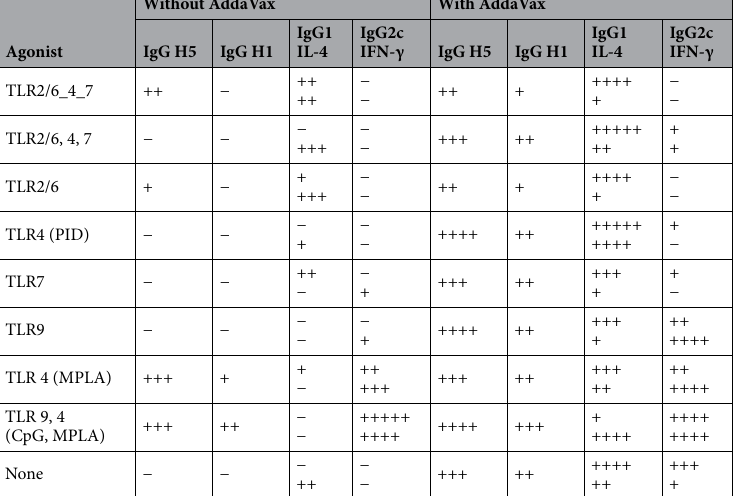
Overall, three main arms are delineated: T lymphocytes (which also includes NK/T cells, γδ T cells, and Tregs), B lymphocytes, and myeloid cells (myeloid dendritic cells, macrophages, monocytes and neutrophils). Interest- ingly, the unbiased hierarchical clustering of cell type transcription profiles placed B cells more closely related to myeloid cells than to T cells. The major cell populations were well delineated by marker genes. Thus, the T cells cluster show elevated expression of Trac, Trbc2, Cd3g and Cd3d (TCR α and β chain constant domains, and CD3γ and δ chains, respectively). Others include Ms4a4a and b (CD20 homolog expressed on mature Th1 cells 45 ); Tcf7 (T cell-specific transcription factor 46 ); and Skap1 (regulator of TCR signaling through MAP kinase 47 ). Nkg7 and Ctsw genes (NK cell granule protein 7 and cathepsin W) are particularly elevated in NK/T cells and play roles in cell-mediated killing by NK and CD8 T cells 48,49 . Also of note is expression of Il2rb (IL2 receptor β chain) which is expressed in NK/T and regulatory T cells (Tregs) at this time point. Also expressed in Tregs is the signature gene Izumo1r ( Folr4 ; folate receptor) 50,51 . The B cells arm shows elevated expression of Cd79a and Cd79b (BCR CD79α and β chains); Ebf1 (B cell-specific transcription factor 52 ); Ighm (IgM heavy chain); and Cd74 (MHC class II invariant chain 53 ). Cells in the myeloid cell express Fcer1g (IgE Fc receptor); Tyrobp (an immunoreceptor-associated tyroskine kinase); and Ifitm3 (IFN-induced transmembrane protein 3), an anti-viral protein which restricts the entry of several viruses into host cells 54 . Among the myeloid cells, neu- trophils show expression of S100 family proteins, including S100a8 and S100a9 (myeloid-related proteins 8 and 14), which are known to be released by activated phagocytes and amplify the inflammatory effect of LPS medi- ated through TLR4 55 . Also expressed in neutrophils is Msrb1 (methionine reductase) which appears to enhance the expression of anti-inflammatory cytokines by macrophages 56 , and Hp (haptoglobulin), a major acute phase protein. These data serve as an additional verification that the SVM correctly identified the cell types. Interest- ingly we found a small population of B and T cell doublets which were identified due to their expression of both T cell markers (Cd3g) and B cell markers (Cd79a) and an unbiased doublet detection algorithm (Supplementary Fig. S3B–D). Doublets in droplet-based sequencing platforms can be indicative of juxtacrine signaling. We then asked whether the differential IgG2c>IgG1 response characterized above could be corrobo- rated using the transcriptomic data. We found Ighg2c , Ighg2b and Ighg1 genes were all upregulated in B cells from immunized mice relative to naïve mice (Supplementary Fig. S4 and Fig. 8C), with log2-fold changes of 6.21 (p-value = 2.14 × 10–93), 4.35 (p-value = 2.33 × 10–281) and 2.69 (p-value = 1.10 × 10–158), respectively (Mann–Whitney U rank-sum test). This is consistent with the moderately skewed IgG2c>IgG1 response observed by IgG isotyping after IVAX-1 administration (Fig. 5a). We also compared the expression of the Ifng gene in naïve and immunized mice (Fig. 8D), which showed IFNγ was expressed by both CD4 and CD8 T cells, with log2-fold increases of 0.7 (p-value = 0.28) and 0.9 (p-value = 0.69), respectively (Mann–Whitney U rank-sum test), consistent with a robust IFNγ response in T cell recall assays (Fig. 5B). Interestingly, intracellular cytokine staining suggested IVAX-1 was not a strong inducer of antigen-specific CD8 cells (Fig. 7B), although as men- tioned above, this may reflect suboptimal restimulation conditions for CD8 cells in the recall assay. Overall, these data show that the transcriptomic Th1/Th2 balance matched that defined by IgG subtyping and cytokine expression in T cell recall assays.